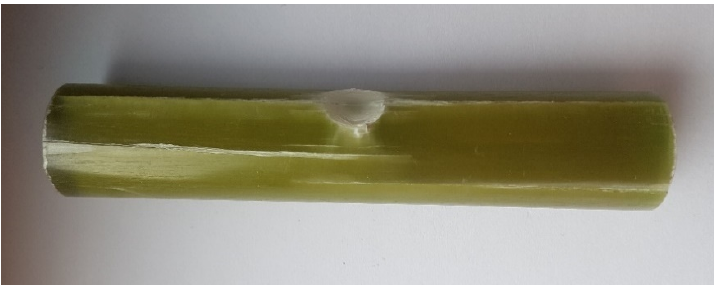
Figure 10. Indentation at the point of operation of the crosshead of the strength testing machine, long axial crack and cracks on the side surface of sample C3. Figure 9. Long axial crack in the lower part of sample C1.